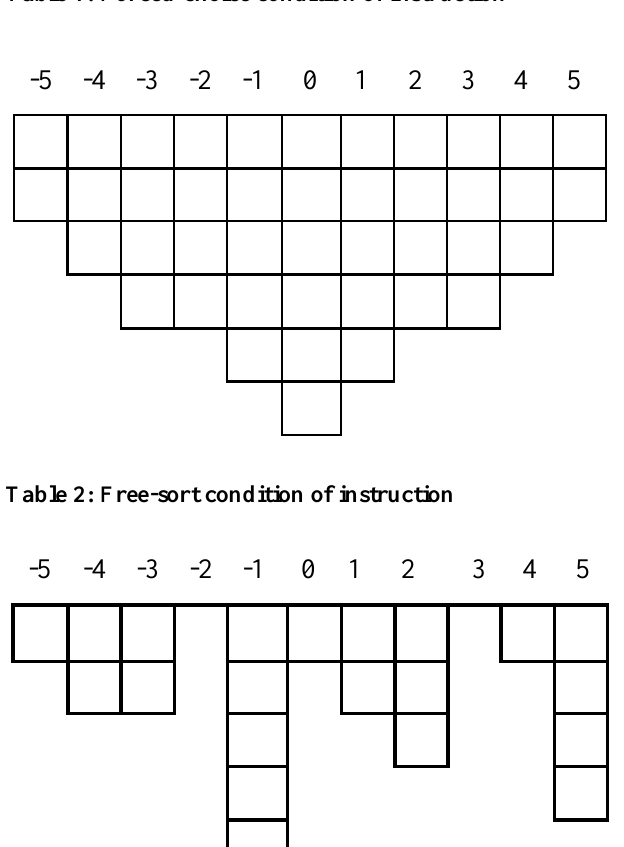
Table 1: Forced-choice condition of instruction -5